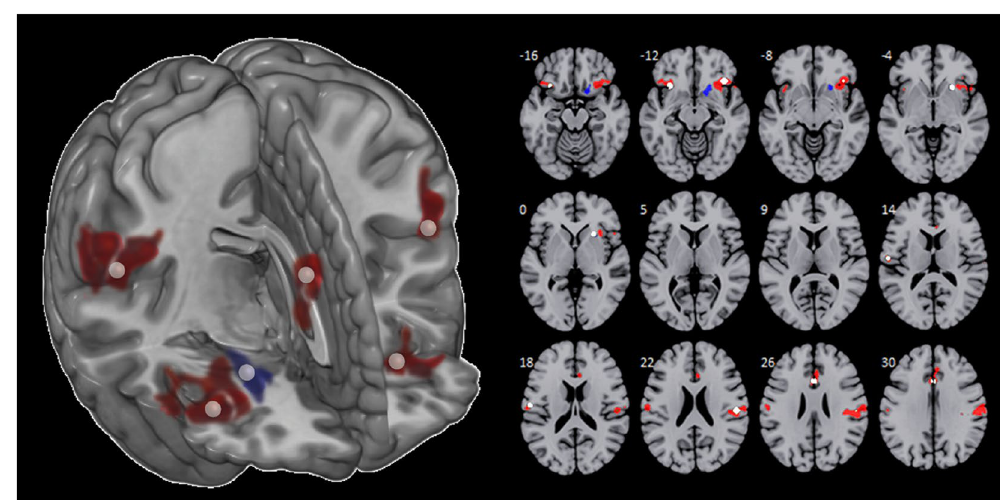
Figure 3. Habituation effects for painful and non-painful stimulation. Clusters showing habituation-related effects (Run 1 > Run 4) separately for painful (red) and non-painful stimulation (blue). ROI definition based on peak voxels as center for 4 mm spherical ROIs (white spheres) that were used in subsequent